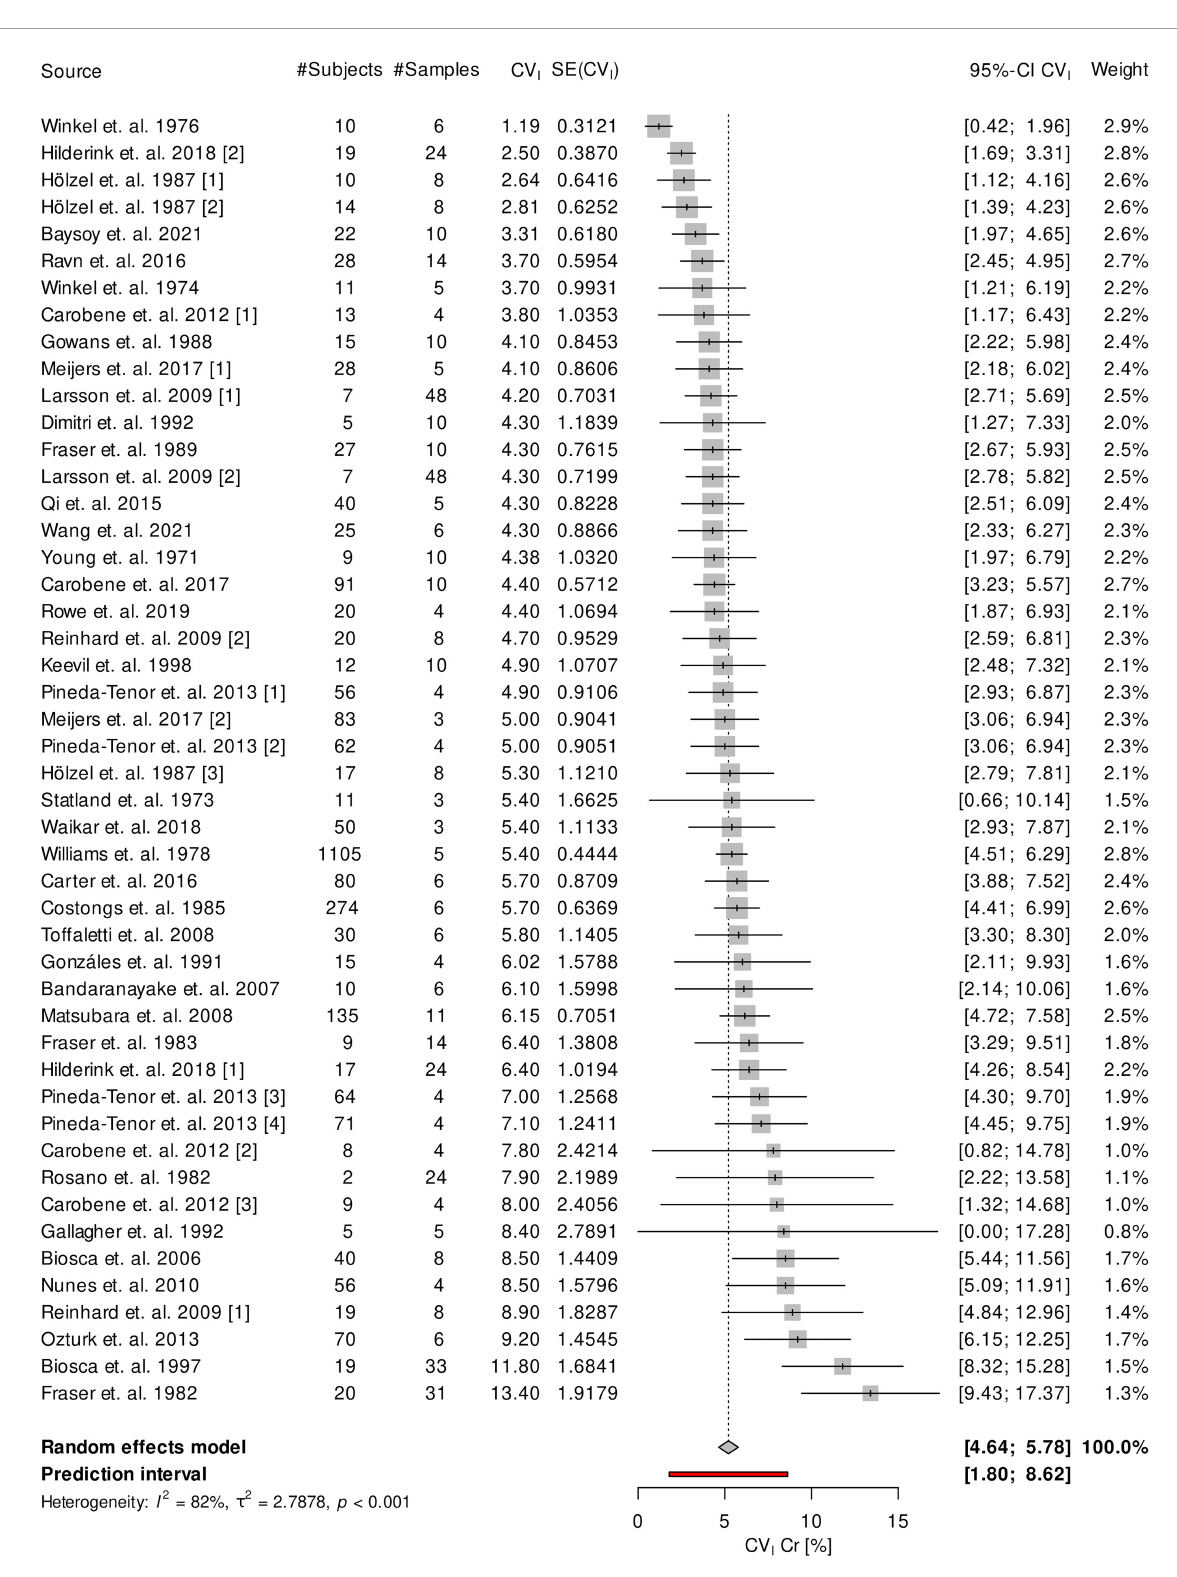
FIGURE2 Forest plot of the meta-analysis of CV I of creatinine. SE, standard